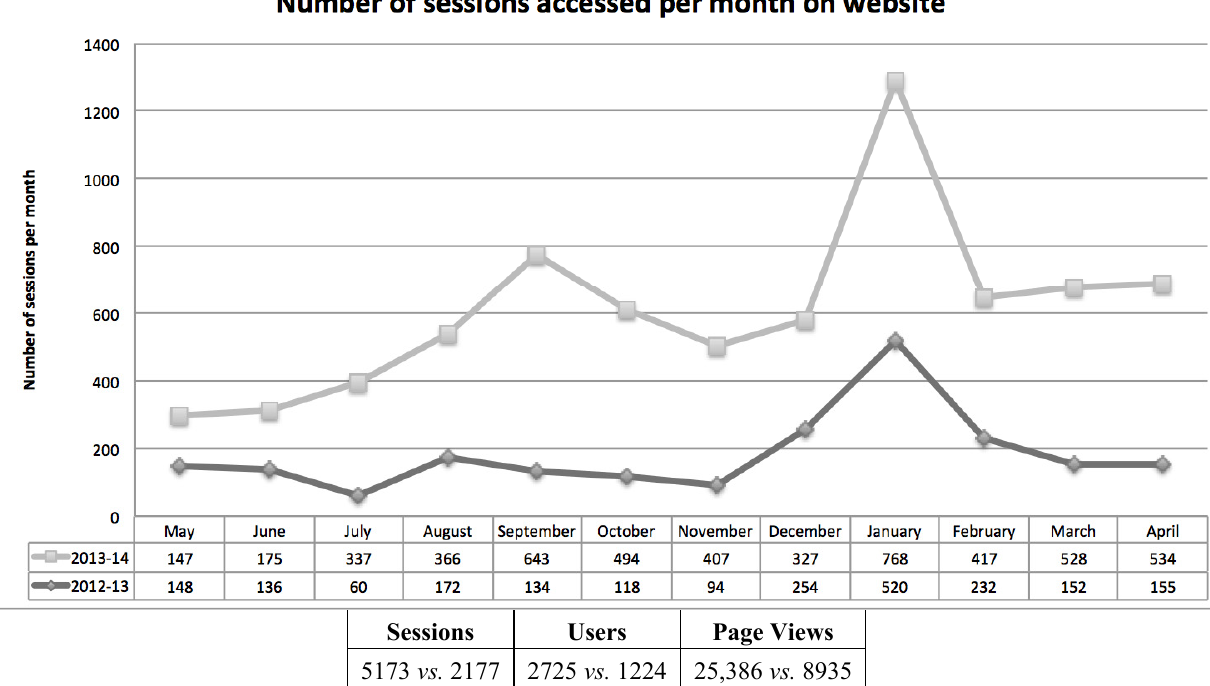
Sessions Users Page Views 5173 vs. 2177 2725 vs. 1224 25,386 vs.